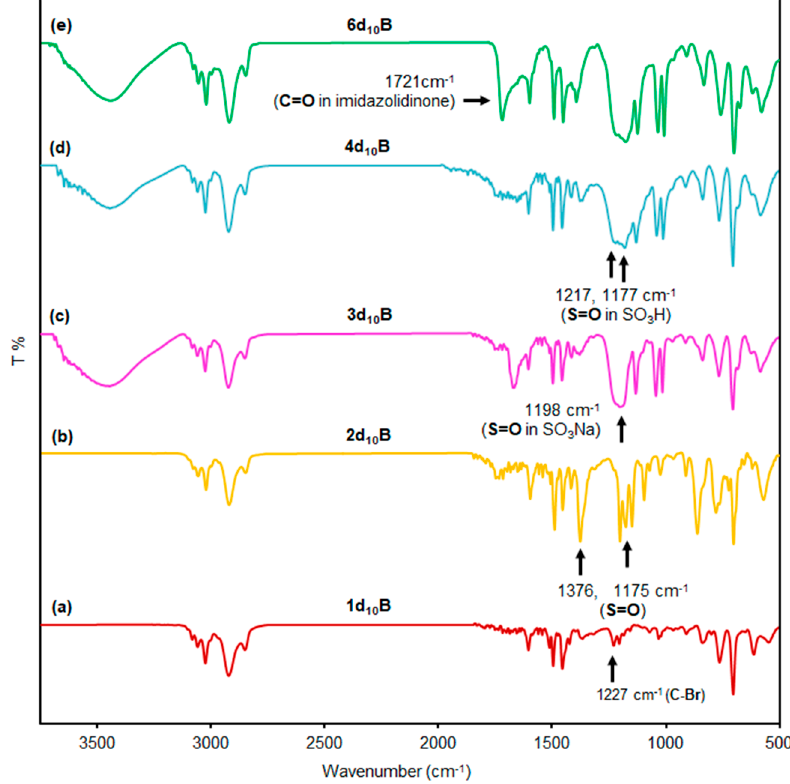
Figure 1. FT-IR spectra. ( a ) 1d 10 B , ( b ) 2d 10 B , ( c ) 3d 10 B , ( d ) 4d 10 B , and ( e ) 6d 10 B .